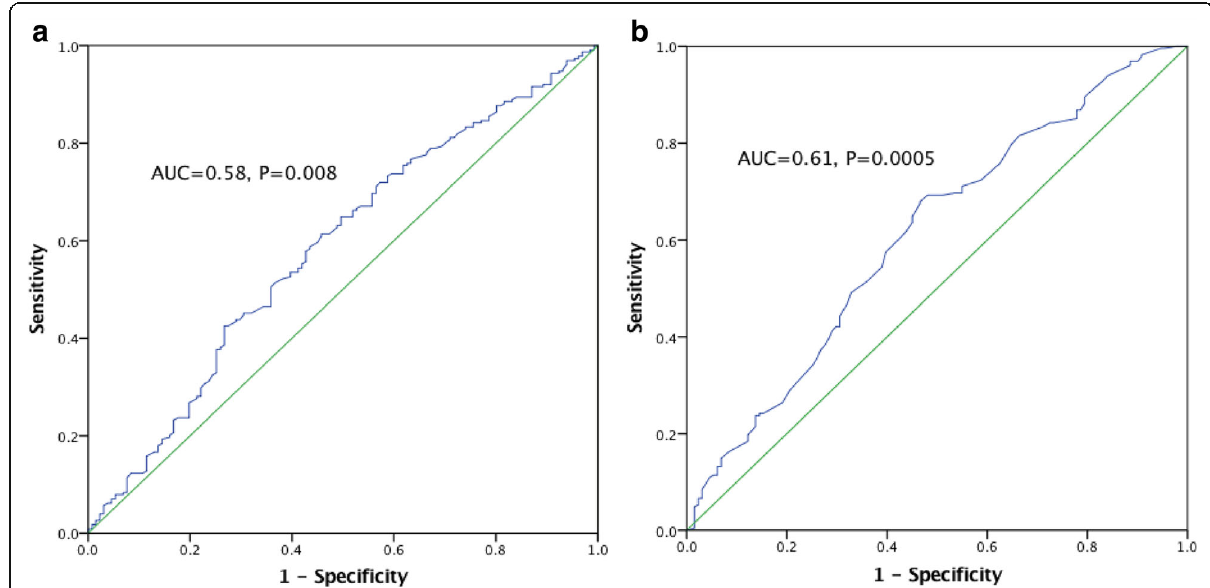
Fig. 1 AUC for the MM cohort considering all genotype SNPs ( a ) and only those SNPs that individual exhibit a nominal level of significance ( b